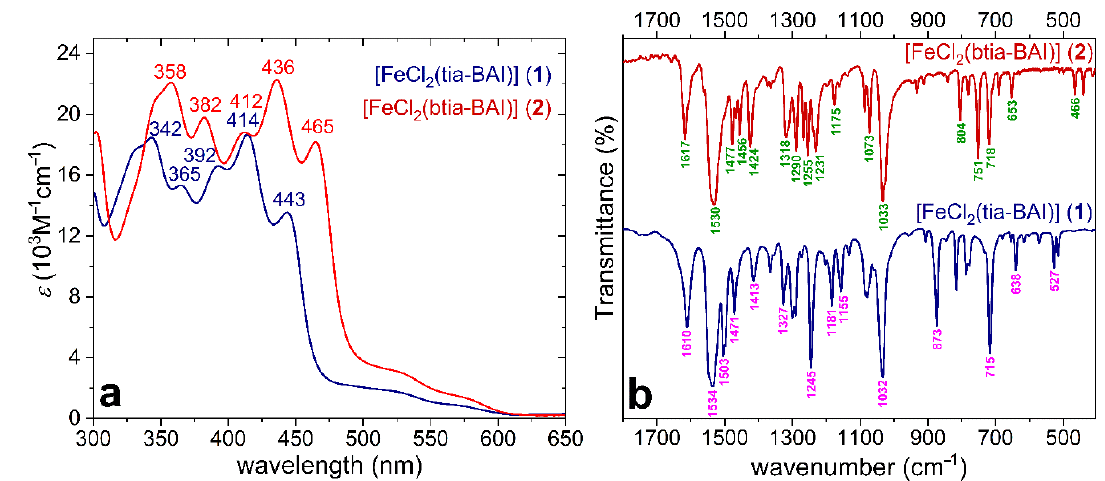
Figure 2. ( a ) UV-visible absorption spectra of 1 and 2 in dry DCM, the wavelengths for the characteristic ILCT bands are given with numbers ; ( b ) FTIR spectra of 1 and 2 as solid dispersed in KBr pastille.